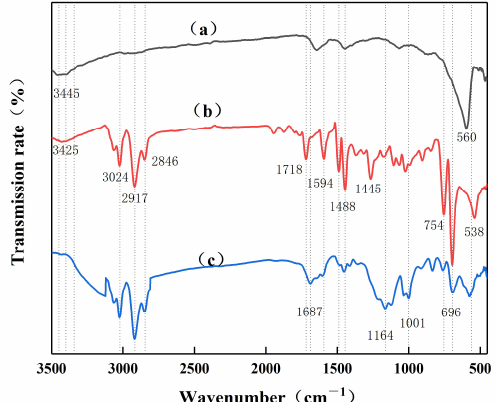
Figure 3. Infrared spectra of Fe 3 O 4 ( a ), Fe 3 O 4 @PS ( b ) and Fe 3 O 4 @SPS ( c